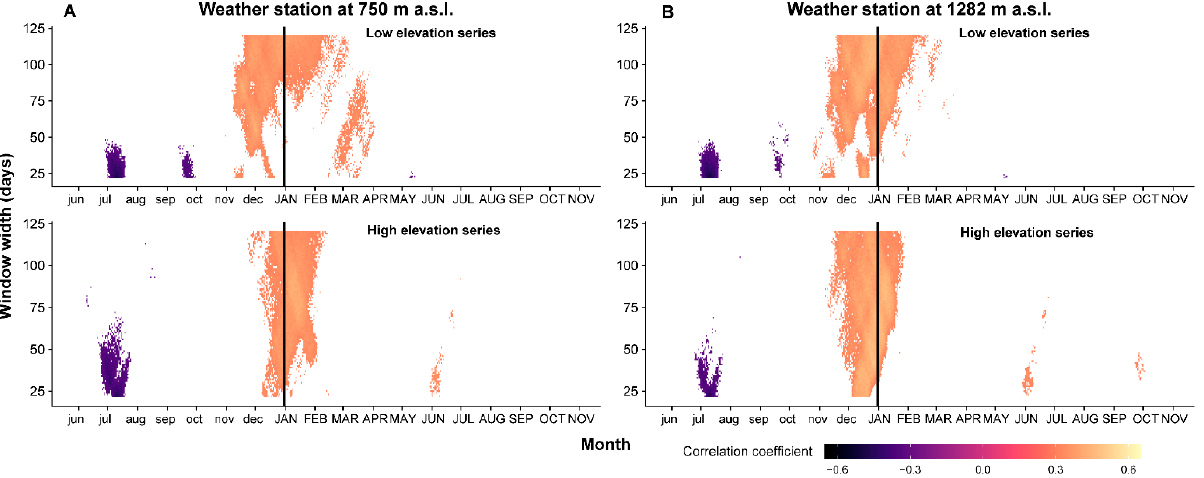
Figure 2. Correlation between TRW residual index chronologies and cumulative daily temperature from valley weather station (Joseni) ( A ) and from up-hill weather station (Bucin) ( B ) (vertical black line represents the limit between previous (with lowercase) and current (with uppercase) year).